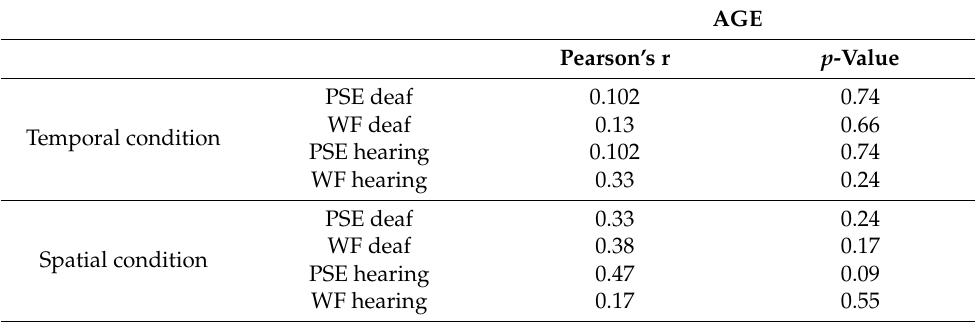
Figure 2. The top panels show the psychometric functions for the discrimination task for both temporal (on the left ) and spatial (on the right ) numerosity. The functions represent the cumulative Gaussian (psychometric) fits to the proportion of trials in which participants judged the test stimulus as more numerous against the difference in numerosity between the test and the reference. The bold data points and curves indicate the average psychometric fit across participants, while light colors indicate single-subject data. The bottom-left panel indicates the average bias, defined as the difference between the PSE and reference values, while the bars on the bottom right panel indicate the average Weber fractions. Both for the bias and the Weber fraction, the plain bars indicate the temporal task, while the hatched bars indicate the spatial task. Finally, data for hearing participants are shown in green, while data for the deaf group are shown in blue. Error bars represent ±1 SEM. Table 3. Correlations results between the ages of the participants and the JND or PSE of discrimination task 3: